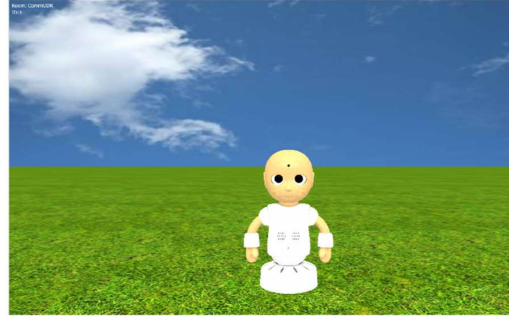
Figure 5. Robot avatar projected in the